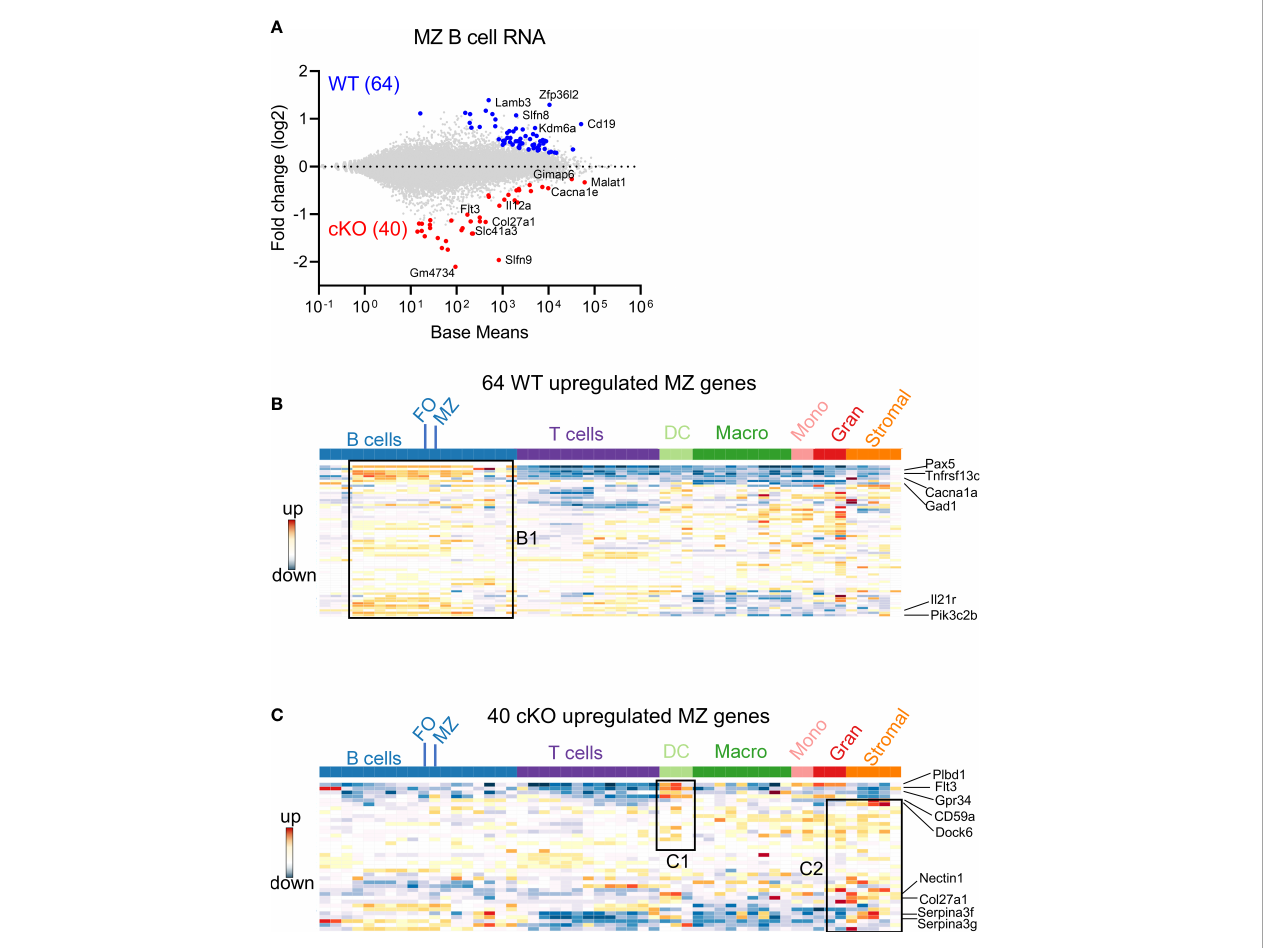
FIGURE 2 Differentially expressed genes in FO and MZ B cells derived from Gtf2i cKO and WT mice. Total RNA was extracted from FO and MZ B cells of WT and cKO mice. The RNA was used for bar-coded library preparations and sequencing. (A) MA plot displaying the log fold-change compared with mean expression and showing the DEGs of the WT MZ B cells (64 genes) and of the cKO MZ B cells (40 genes). (B) 64 WT MZ speci fi c genes were queried against the ImmGen-Database and the heatmap shows the expression levels of these genes in B and other immune cells. Box B1 shows genes that are signi fi cantly enriched in the different B cell compartments. (C) Heatmap shows the expression levels of the 40 cKO MZ speci fi c genes when they were queried against the ImmGen-Database. Genes that are enriched in DC compartment are shown in box C1 while genes that are enriched in stromal and granulocytes are shown in box